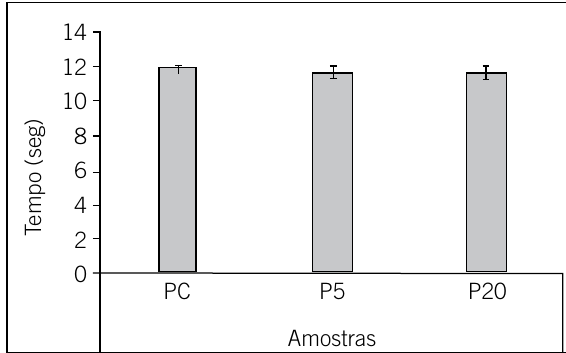
Figura 1 – PC: plasma